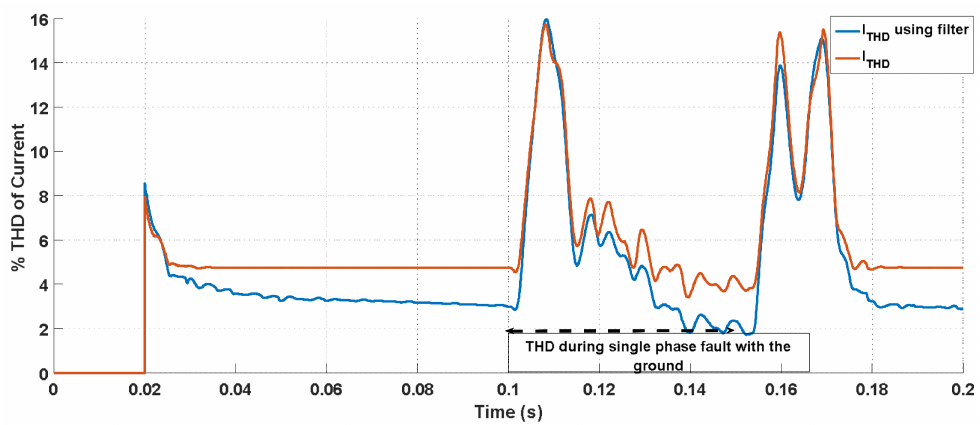
Figure 18. Compare %THD of current calculation using THD filter & without THD filter.